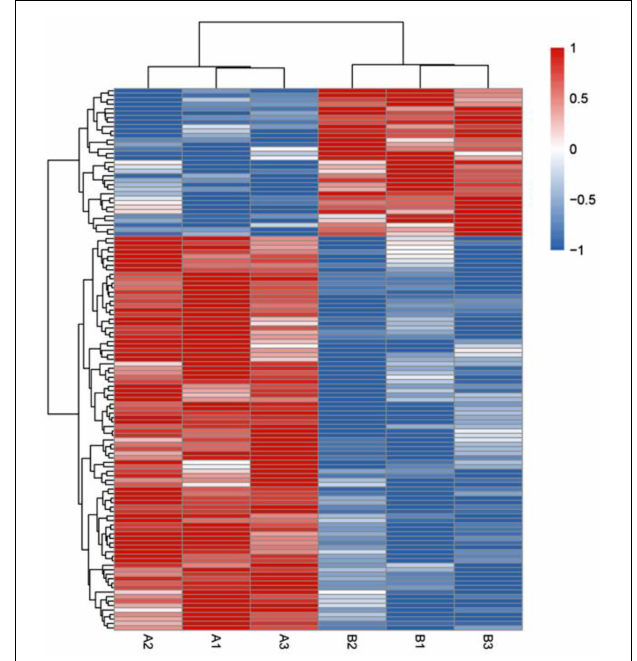
FIGURE 3 | Heatmap showing hierarchical cluster analysis of lysine-acetylated proteins in control groups (A1–A3) and exercise groups (B1–B3). The Euclidean distance was used as the distance metric, and the clustering criteria were complete. The heatmap includes an accompanying supplemental table with the list of the proteins used and their fold change (supplemental “DEP heatmap”).